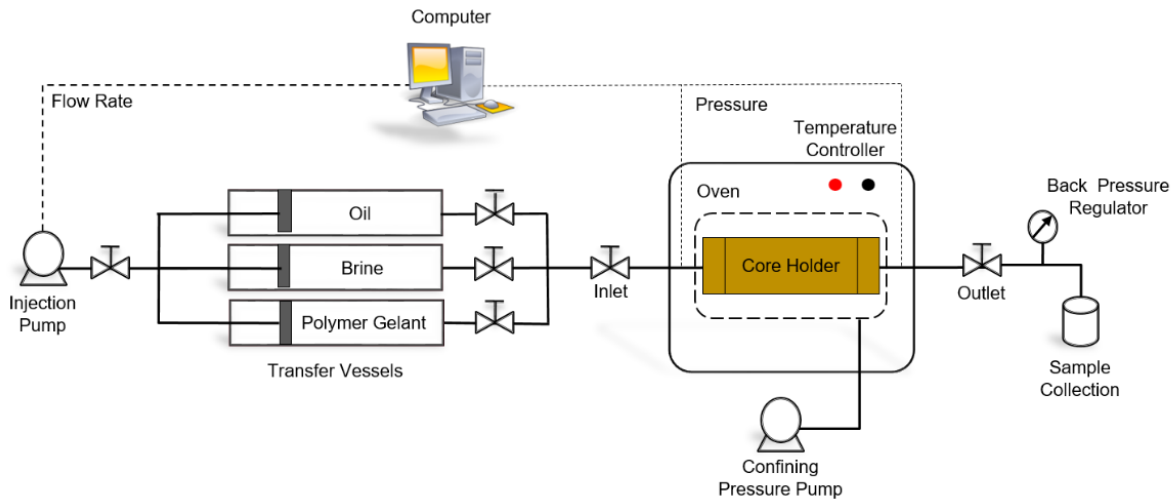
Figure 3. Schematic diagram of the coreflooding set-up.